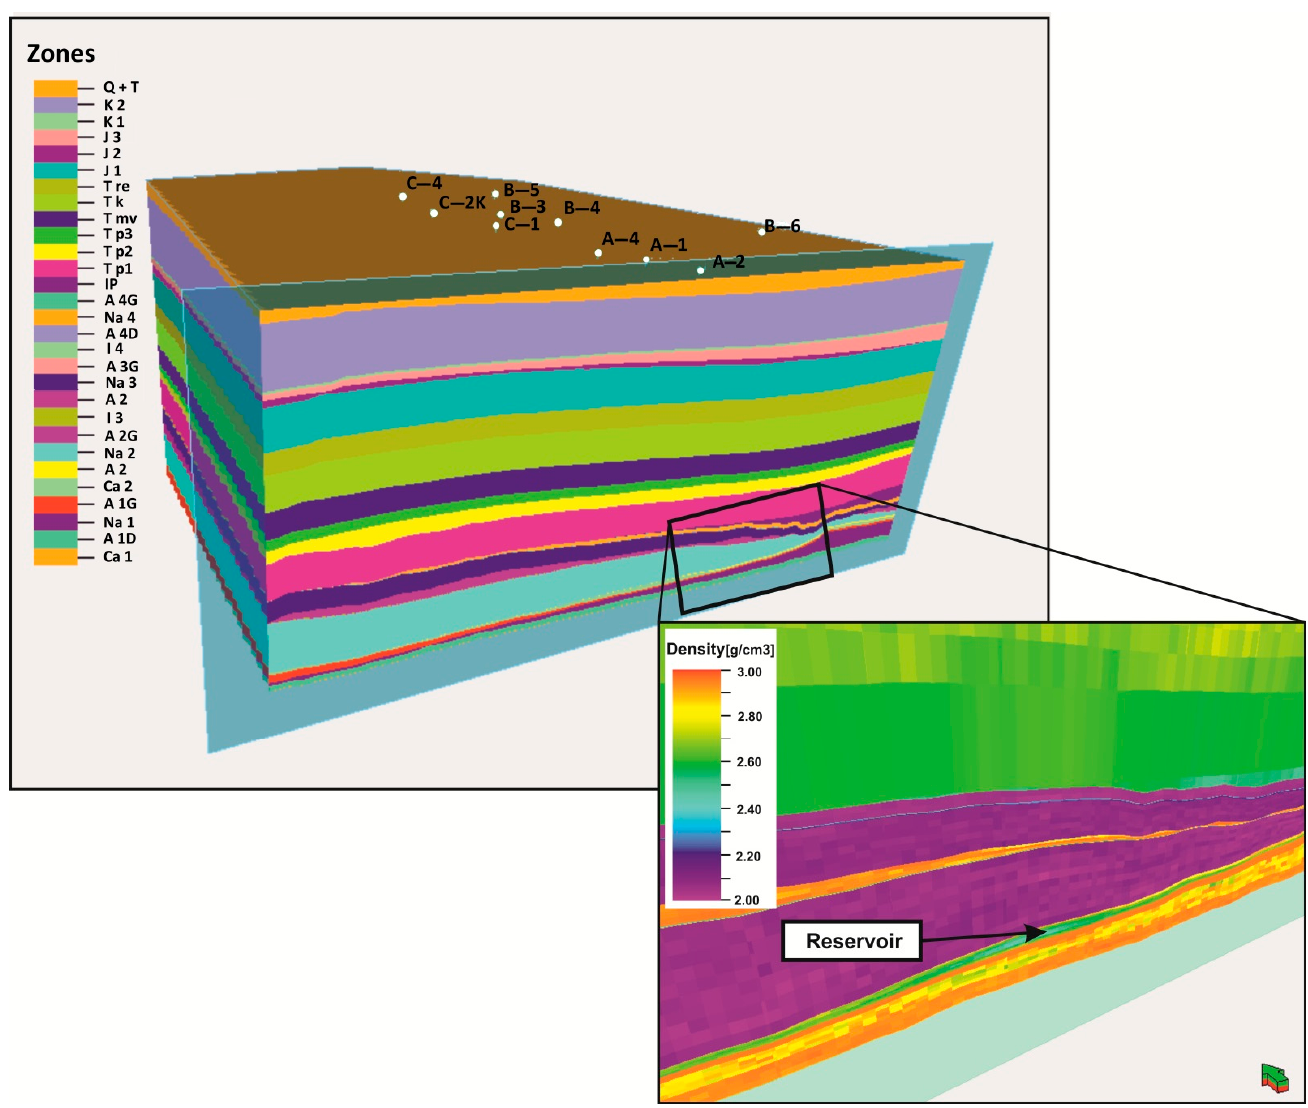
Figure 4. Cross—sections in 3D structural model for the entire profile ( left ) and for the interval of interest ( right ) showing the distribution of density within the target CO 2 storage reservoir Ca2 main dolomite reservoir and the neighbouring rocks.